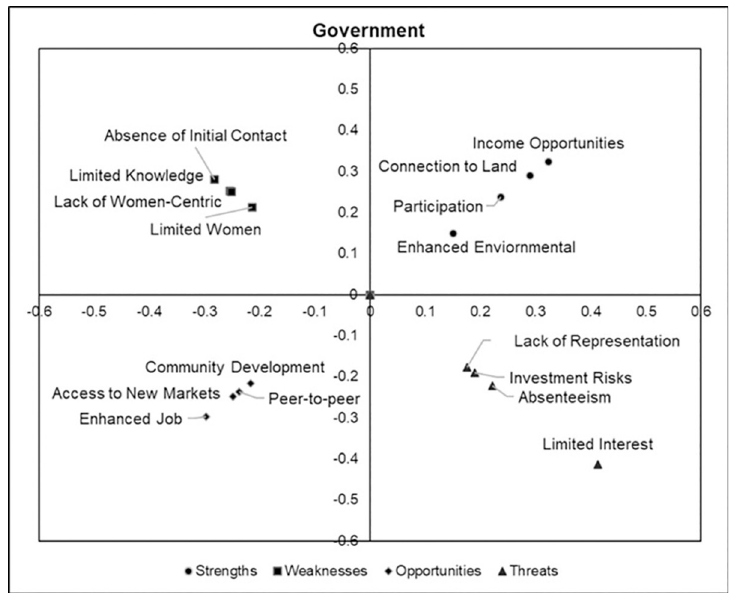
Fig 4. Perception map of factor priorities assigned by government representatives.